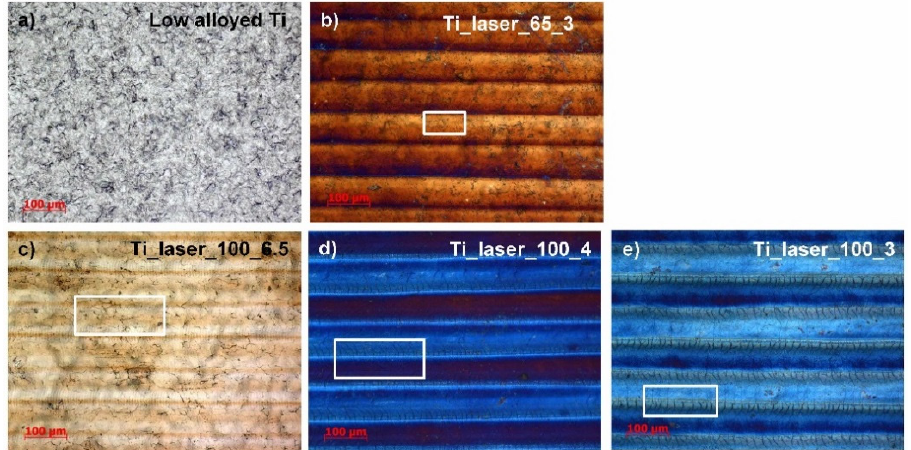
Figure 1. Prepared laser colour marking of low alloyed Ti for the samples presented in Table 1. ( a ) low alloyed Ti; ( b ) sample Ti_laser_65_3; ( c ) sample Ti_laser_100_6.5; ( d ) sample Ti_laser_100_4; ( e ) sample Ti_laser_100_3.